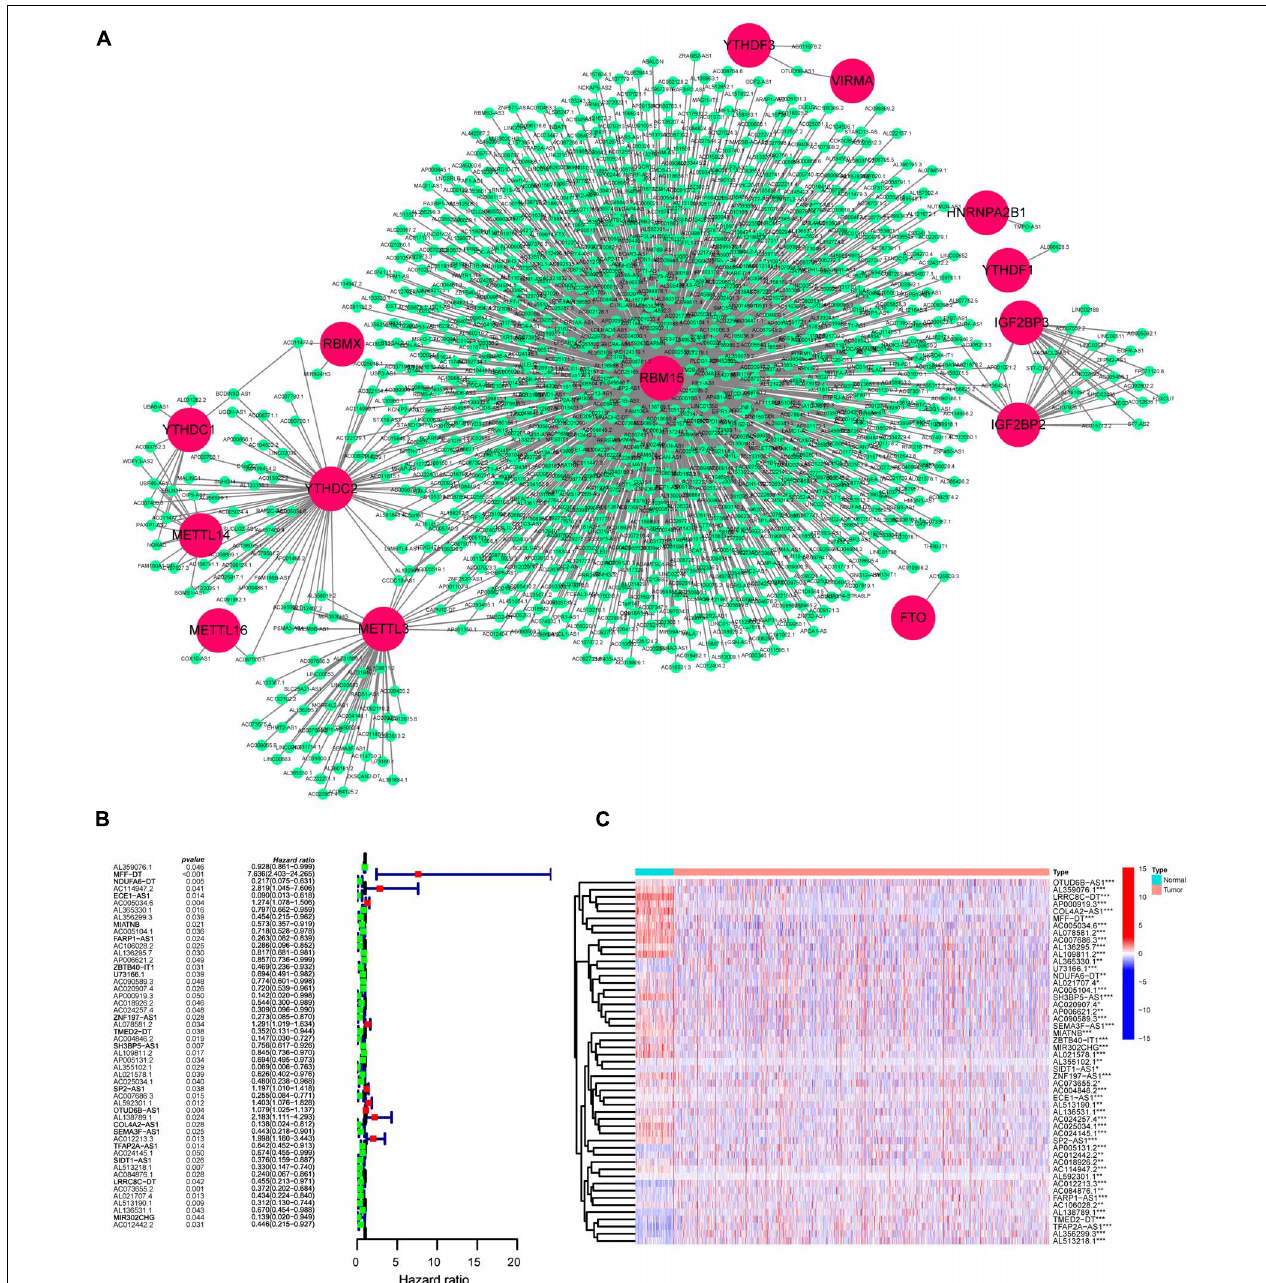
FIGURE 1 | Identification of prognostic m6A-related lncRNAs in BC patients. (A) Construction of the m6A-regulator–lncRNA co-expression network using Cytoscape. Within networks, m6A-related genes are displayed in red nodes and m6A-related lncRNAs in green nodes. (B) A forest map showed 51 prognostic m6A-related lncRNAs identified by univariate Cox proportional hazard regression. (C) A heatmap displayed differentially expressed 51 m6A-related lncRNAs in the TCGA-BRCA dataset using the “limma” method. * p < 0.05; ** p < 0.01; and *** p < 0.001.